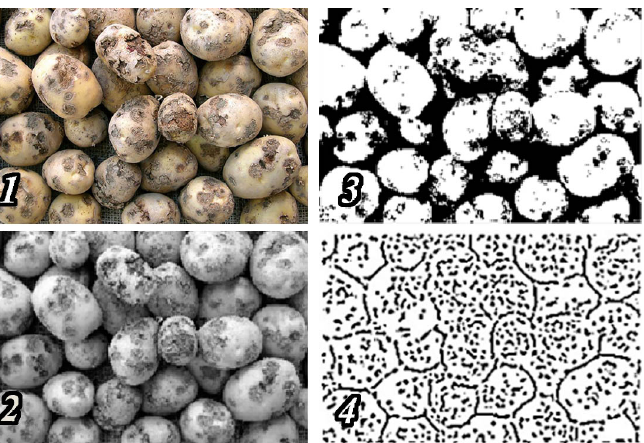
Figure 3. Original and processed images of potatoes ( 1 . The original image; 2 . The image converted to grayscale; 3 . Threshold binarization applied (Otsu’s method); 4 . The adaptive binarization applied (Niblack’s method)).